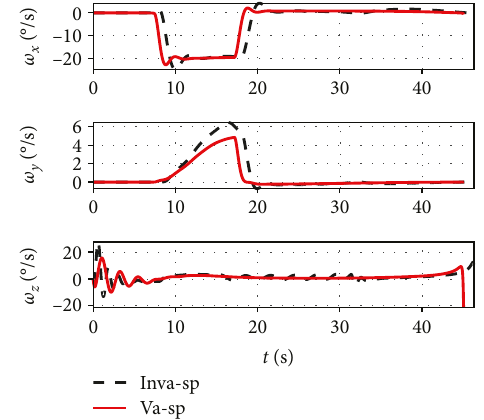
Figure 13: Curves representing the rolling, yawing, and pitching rates. Inva_sp: invariable span; Va-sp: variable span.